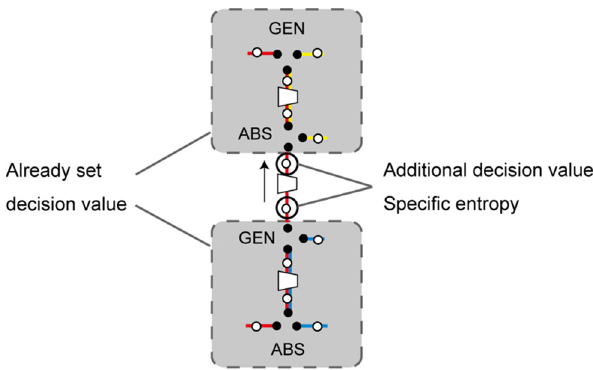
Figure 7. An example of topologies that require definition of several additional design parameters. (red line—refrigerant, blue line, yellow line—absorbent solution).